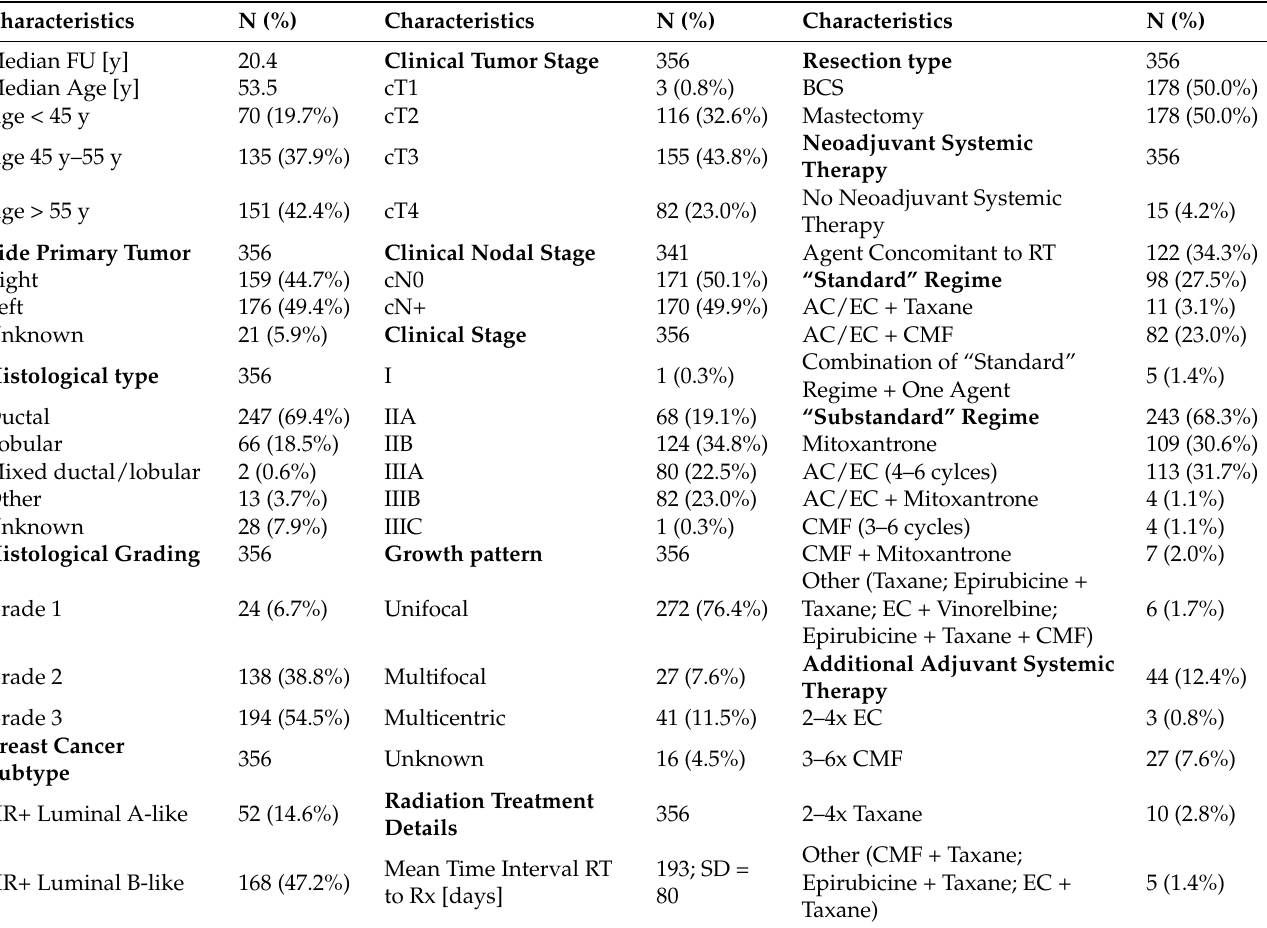
Table 1. Overview of the baseline and treatment characteristics of the patient cohort. Data are presented as absolute numbers and